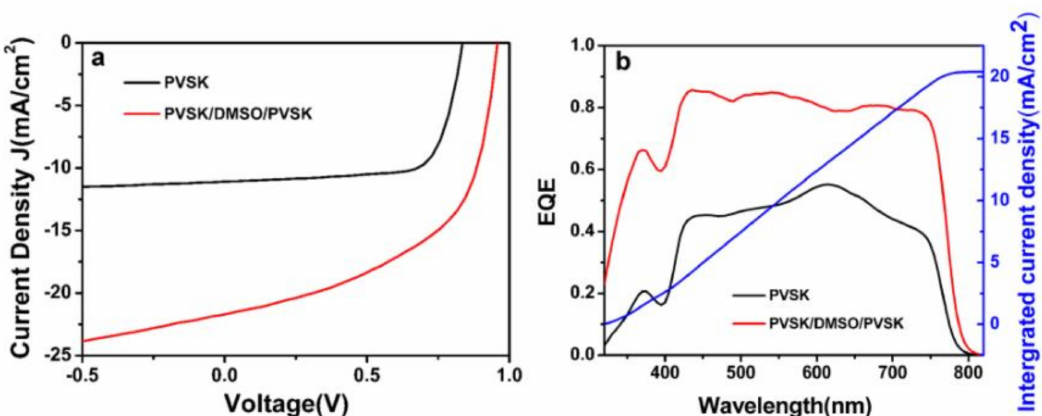
Figure 1. ( a ) J-V characteristics and ( b ) EQE spectra of the PSCs on a pristine PEDOT:PSS film (PVSK) (dark) and PEDOT:PSS films treated with perovskite layer rinsed away with DMSO (PVSK/DMSO/PVSK) (red) and photocurrent density (blue) calculated by integrating the EQE with the AM 1.5G solar spectrum. Table 1. Performance data of PSCs on a pristine PEDOT:PSS film (PVSK) and PEDOT:PSS films treated with DMSO (DMSO/PVSK) and perovskite layer rinsed away with DMSO(PVSK/DMSO/PVSK).